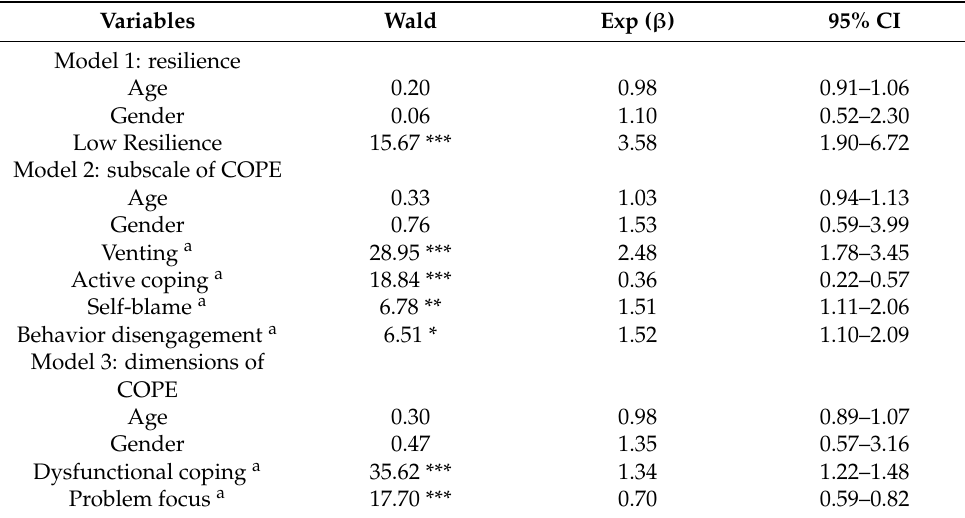
Table 3. Results of logistic regression analysis for the association between resilience or coping strategy and internet gaming disorder (IGD).